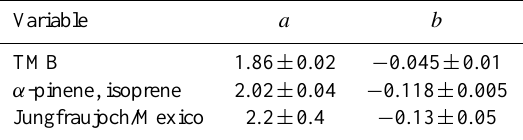
Table 3. Correlation parameters of Eq. (7) for the different